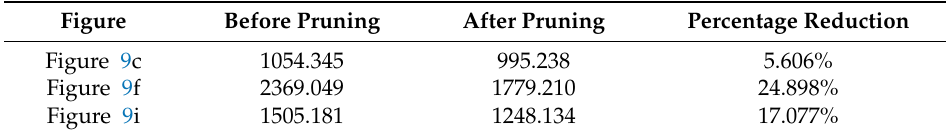
In Figure 10, RRT, RRT-Connect, P-RRT, 1-0 Bg-RRT, and RRT ∗ carry out global path planning in Maps 1, 2, and 3. The final backtracking paths are relatively tortuous when the number of narrow passages